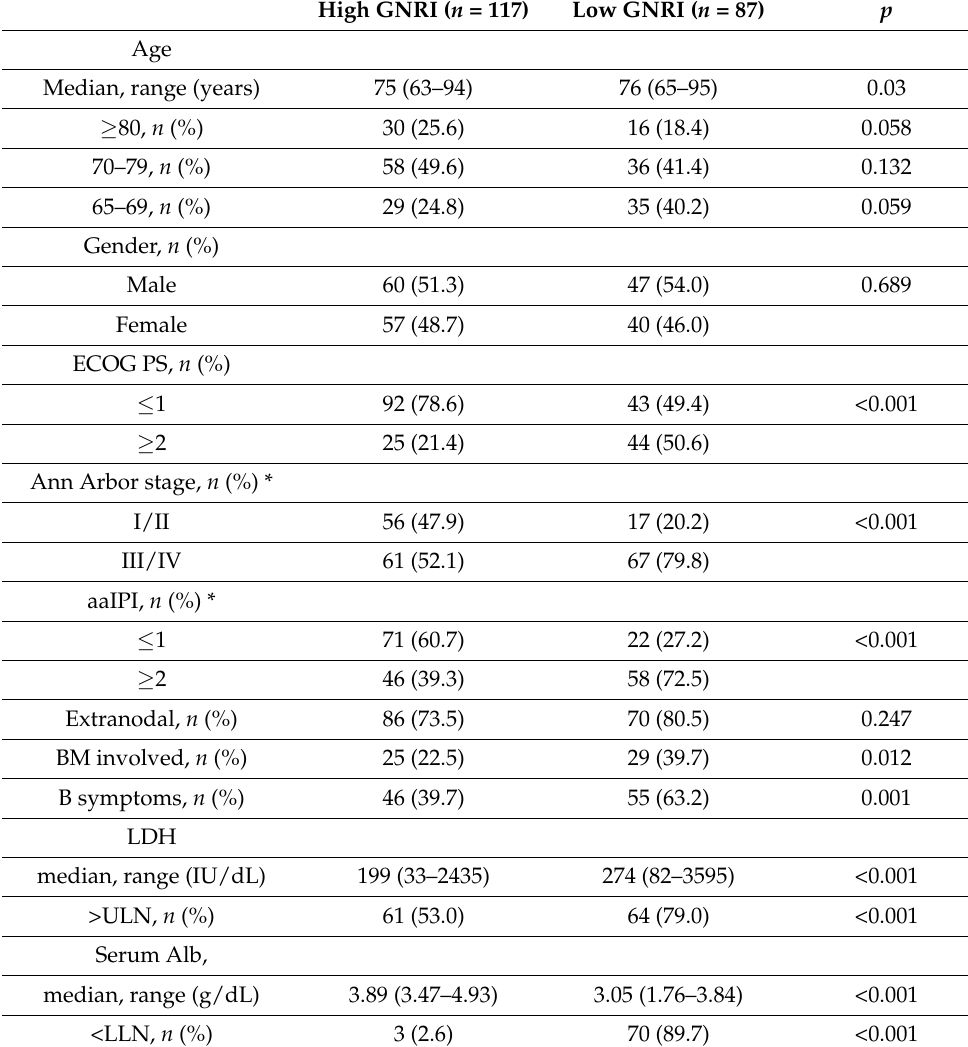
Table 4. Baseline characteristics of DLBCL patients according to the